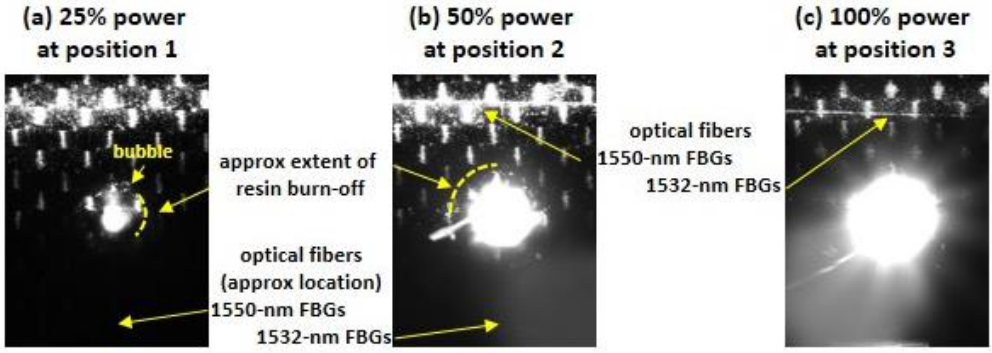
Figure 12. Video frames of the front of the CF composite, captured halfway through the strikes at positions 1–3, respectively. N 2 gas flowed from right to left in each video frame.